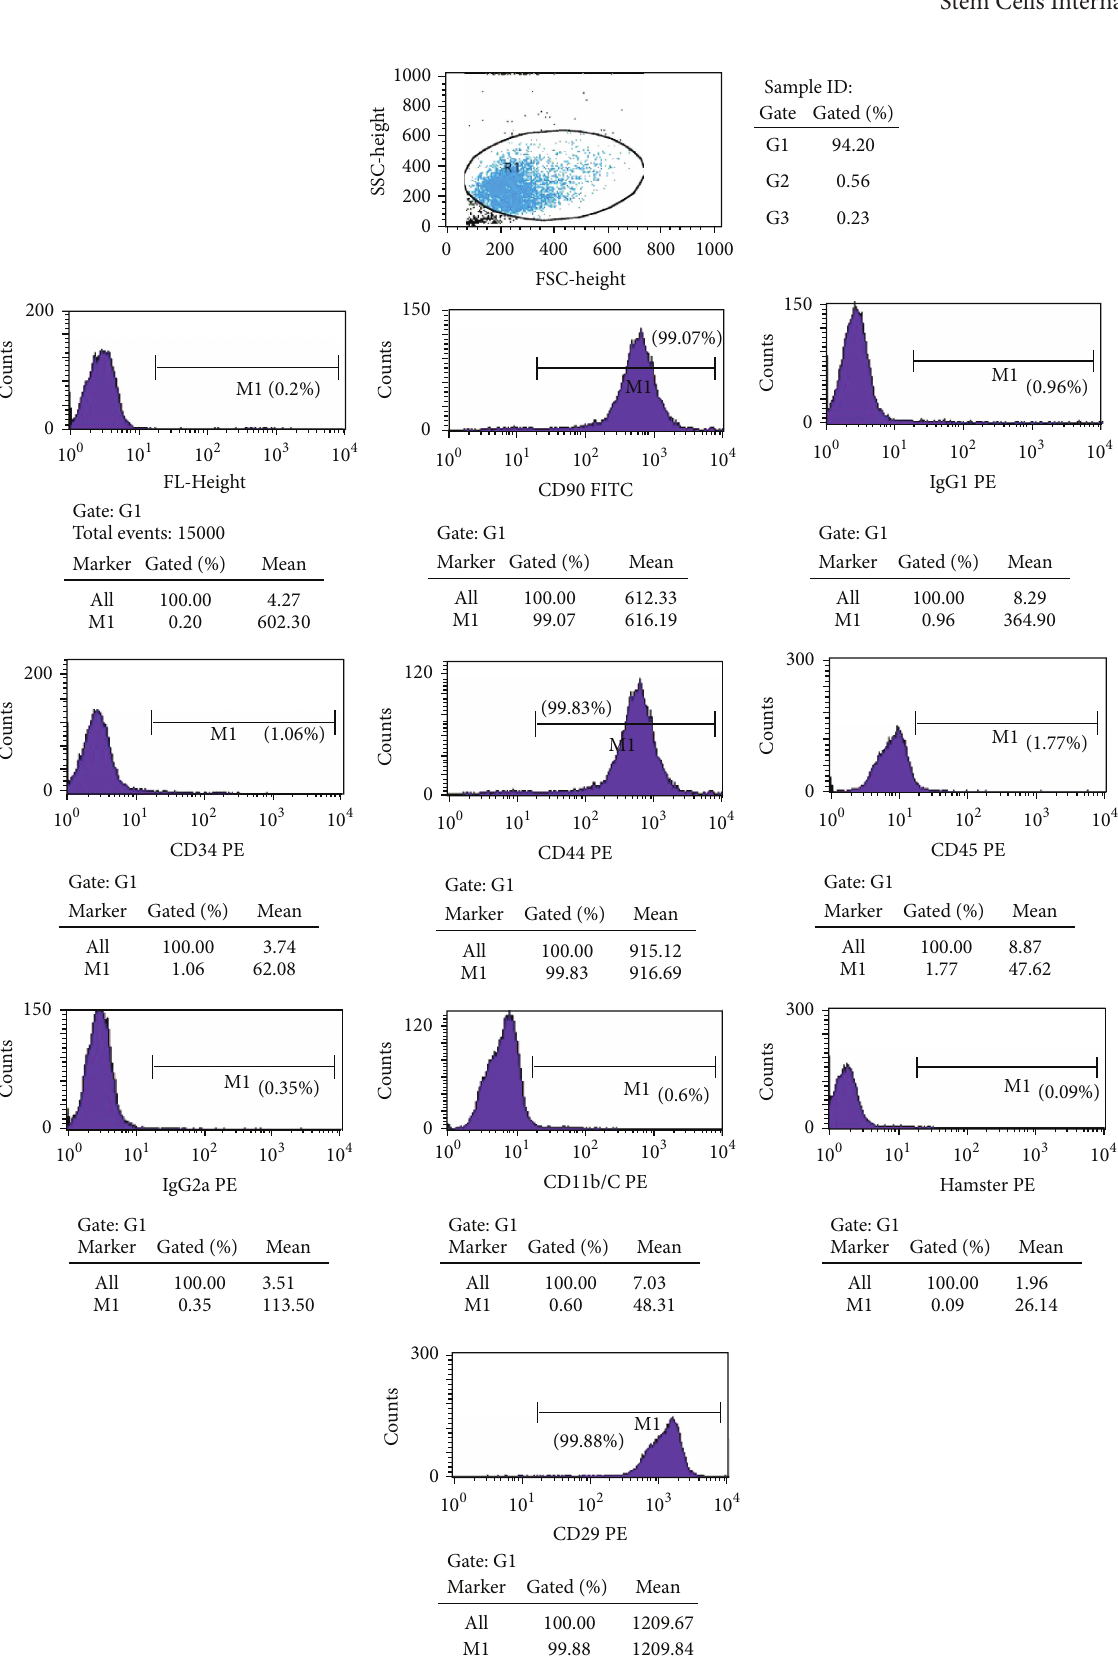
Figure 1: Preparation of BMSCs. The cultured cells were identified with FL1-Height (0.2 % ±1.7 % ) , CD90 (99.7 % ±3.1 % ) , IgG1 (0.96 % ±1.3 % ) , CD34 (1.06 % ±1.3 % ) , CD44 (99.8 % ±4.1 % ) , CD45 (1.7 % ±2.1 % ) , IgG2a (0.35 % ±2.9 % ) , CD11b/C (0.6 % ±1.7 % ) , HAMSTER (0.09 % ±0.7 % ) , and CD29 (99.88 % ± 3.1 % )